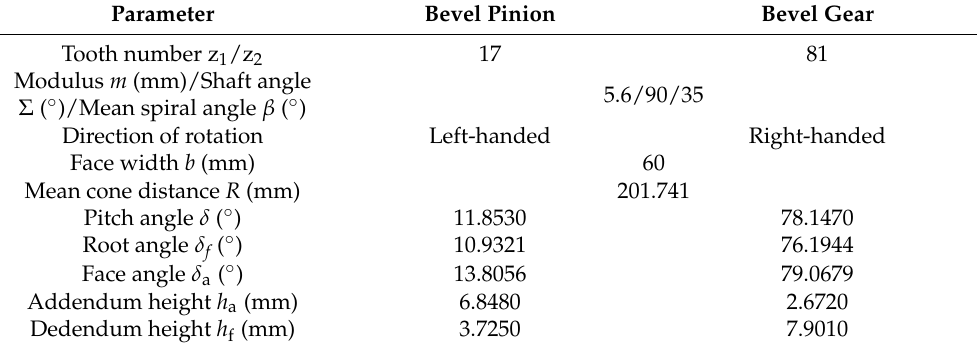
Table 1. Blanks parameters.